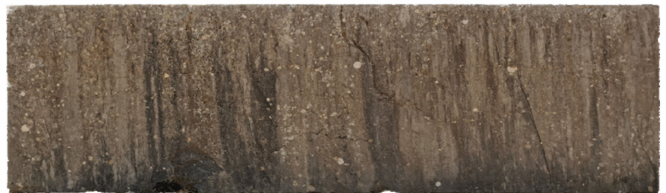
Figure 13. Orthoimage mosaic, cubic stone pedestal at the Temple of Athena and Zeus Sotiros.